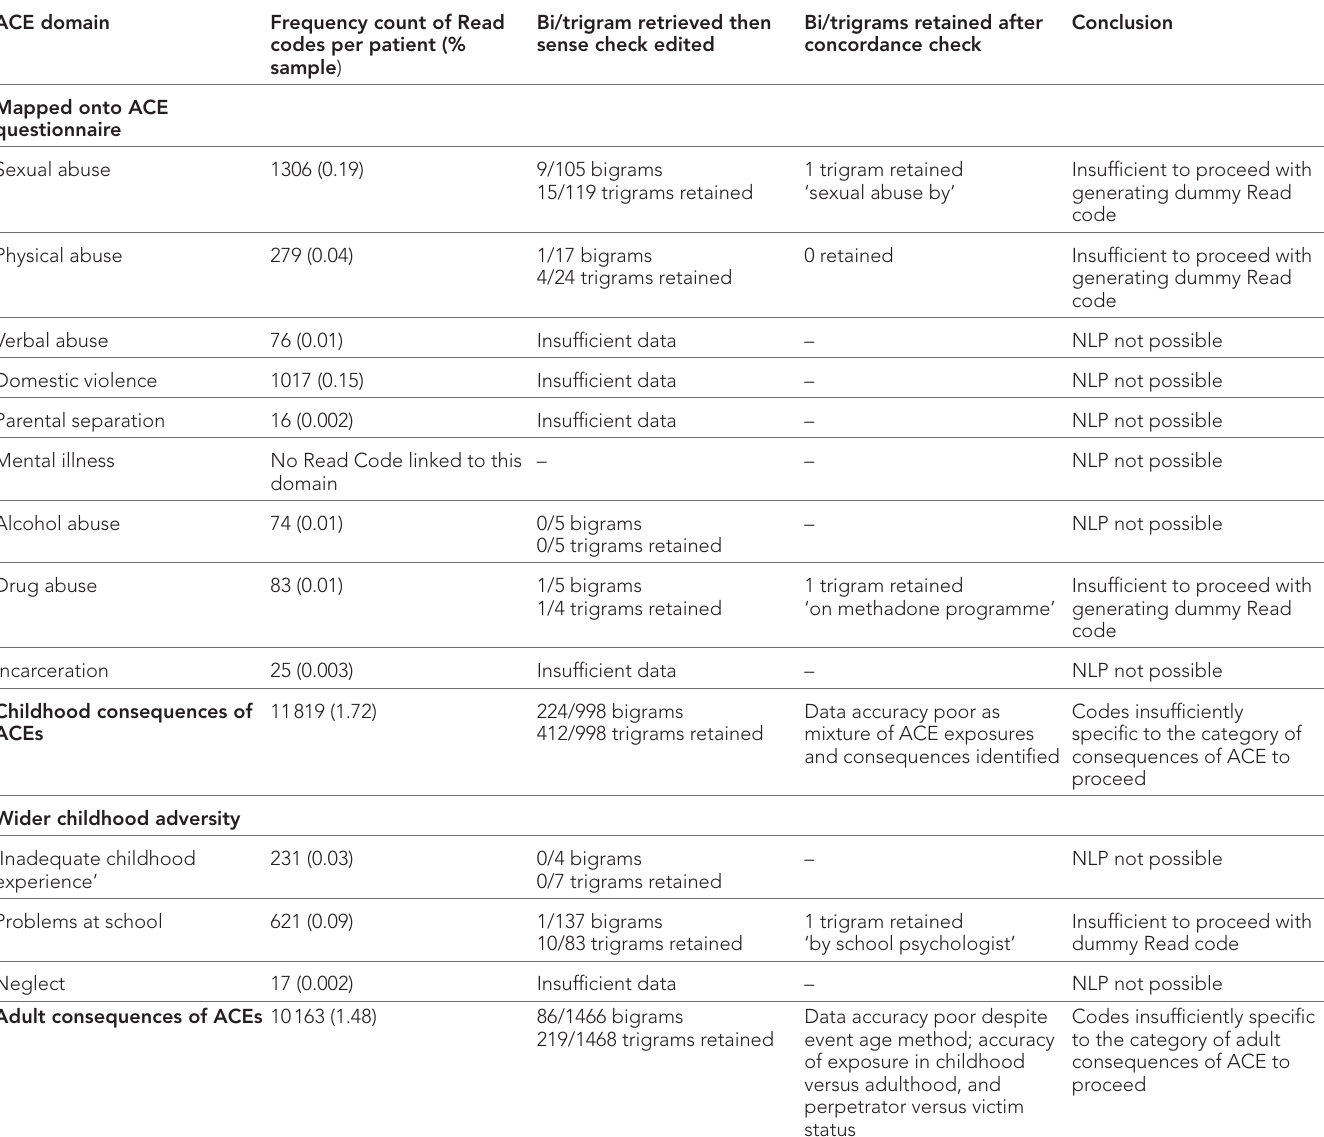
Table 2 ACE questionnaire domains mapped onto Read codes; childhood consequences of ACEs; wider childhood adversity; and adult consequences of ACEs; frequency counts of Read codes recorded and the NLP